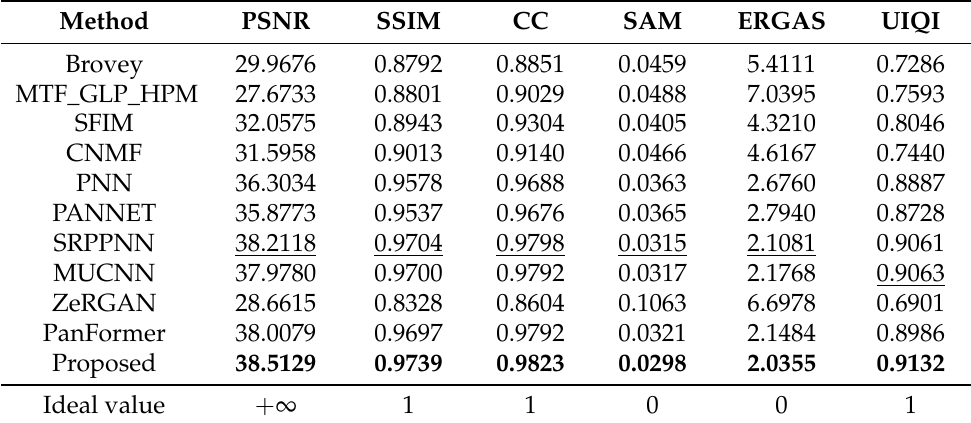
Table 3. Quantitative results of compared methods on the WV3 dataset in reduced resolution. The best values are shown in bold, and those in second place are